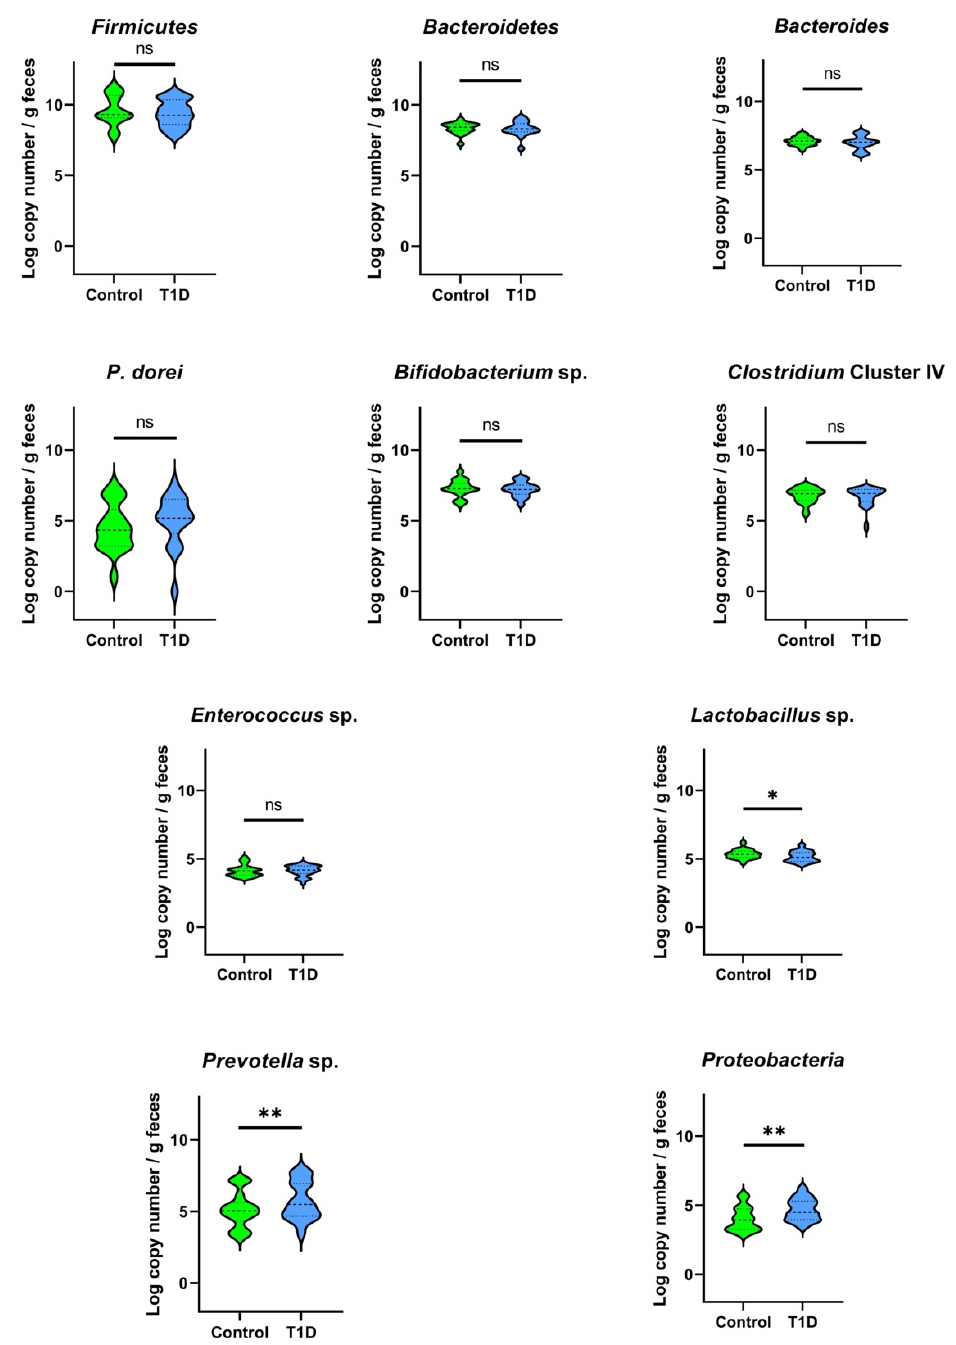
Figure 2. Violin plots reporting the qPCR quantification of fecal bacterial groups in T1D and control children ( n = 17 par- ticipants per group). p- values were computed using the Mann–Whitney U test, * p < 0.05, ** p < 0.001, ns—not